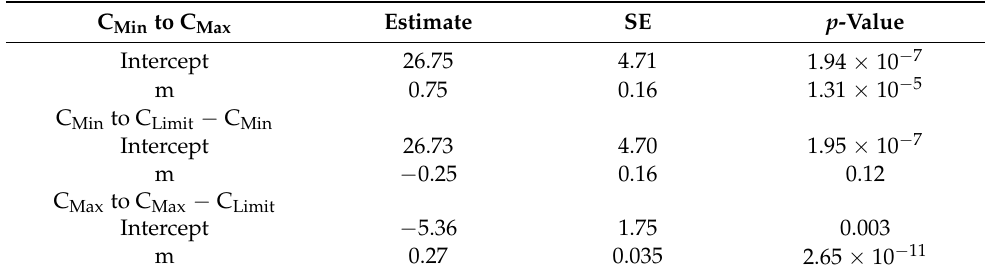
Table 2. Regression parameters of price sensitivity